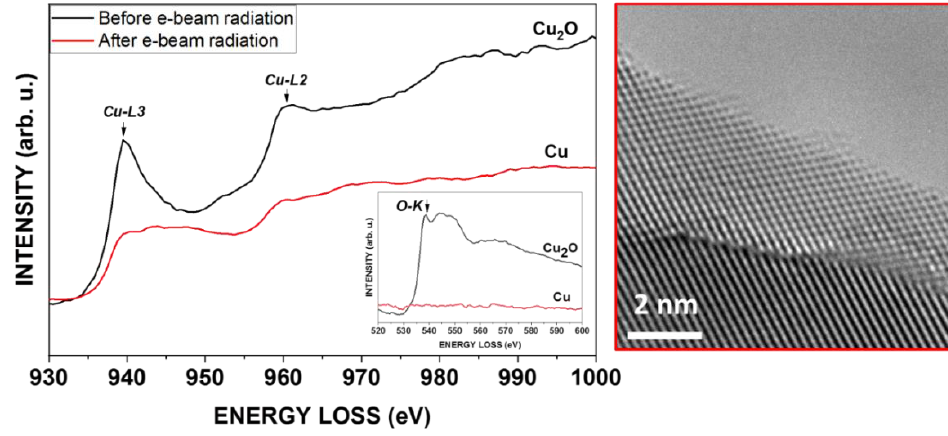
Figure 6. EELS spectra of the Cu 2 O sample before and after electron beam radiation, Cu spectrum analysis with an inset of the O spectrum, and HRTEM micrograph of the investigated area.